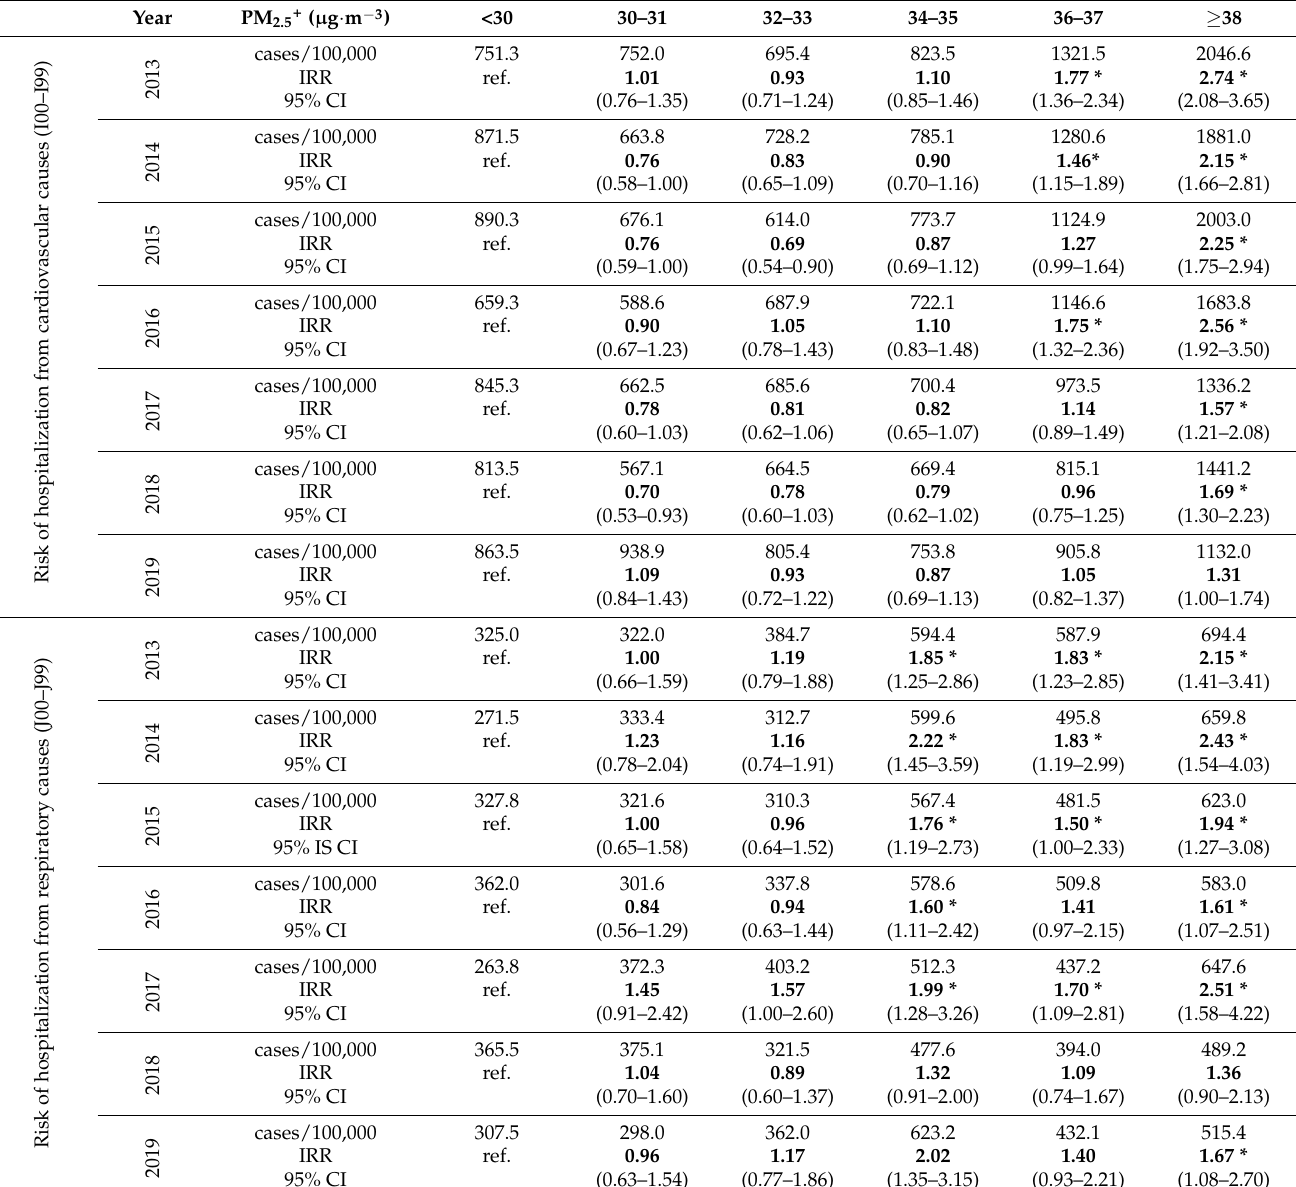
Table 2. Risk of acute hospital admissions for cardiovascular and respiratory diseases according to the concentration intervals of PM 2.5